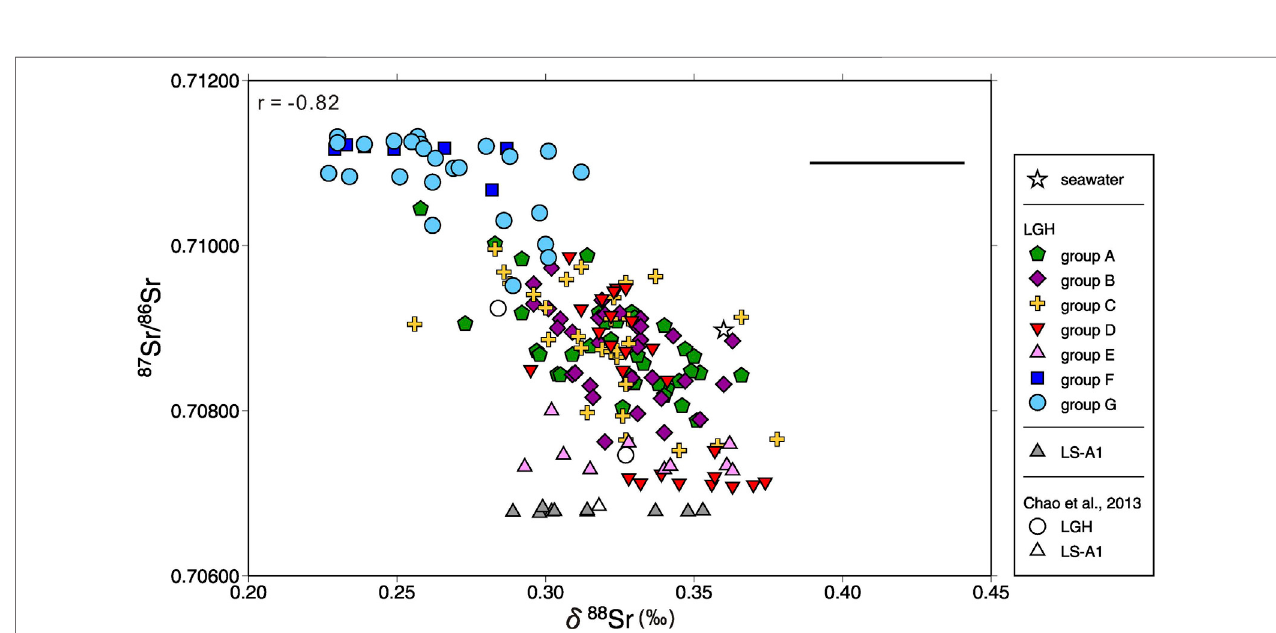
FIGURE5| Plot of 87 Sr/ 86 Srvs. δ 88 Srforallmud volcano fl uidsinthisstudy.Pearson ’ scorrelation coef fi cient rand seawatercompositionareshown forreference. The range of the cross denotes the range of the reproducibility (2 σ ).